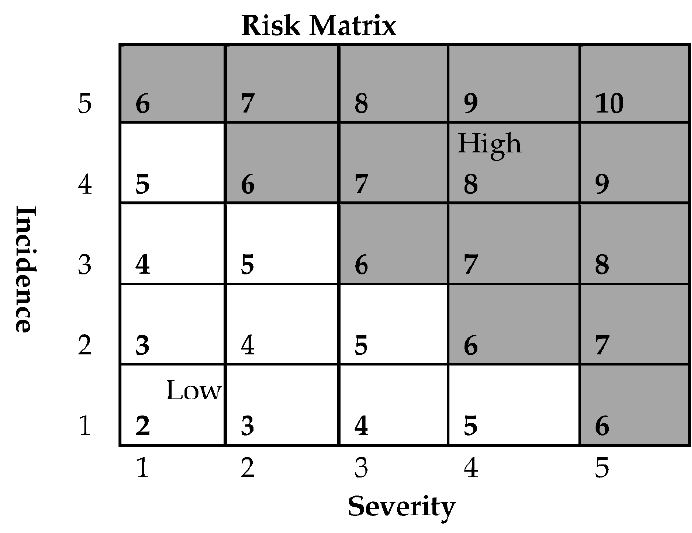
Figure 2. Risk Matrix.